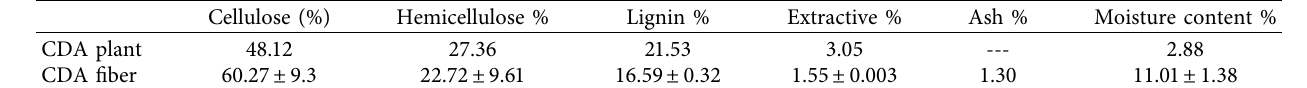
Table 4: Chemical composition of CDA before and after